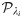
Probabilistic Finite State Machines (PFSMs) describing the microscopic behaviour of an agent in average.Here, the notation Pλi is a shorthand for Pλ(vi) (A) PFSM describing the basic commitment dynamics. Spontaneous transitions are represented by solid lines, interactive transitions by dashed lines. For a complete version with n + 1 states, see panel A in S1 Fig (B) PFSM describing the dynamics of activity change as agents switch from latent to interactive states. Latent states are indicated in grey, while changes in the activity state are represented by dash-dotted arrows. (C) PFSM describing the coupled dynamics of commitment and activity change. For a complete version with 2(n + 1) states, see panel B in S1 Fig.